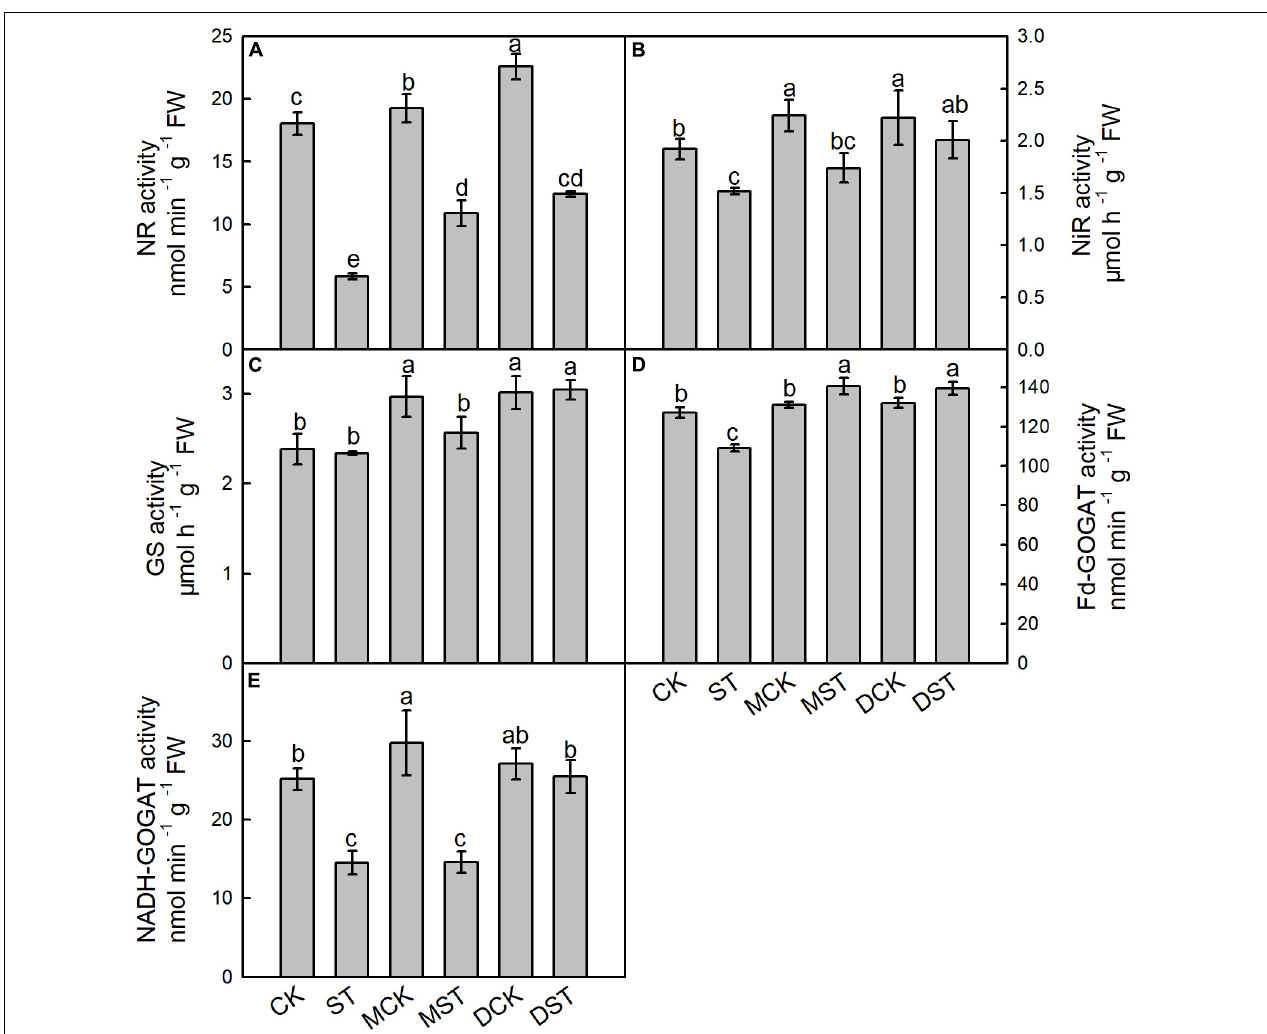
FIGURE 5 | Effects of melatonin and dopamine on activities of nitrate reductase (NR; A ), nitrite reductase (NiR; B ), glutamine synthetase (GS; C ), ferredoxin-dependent glutamate synthase (Fd-GOGAT; D ), and nicotinamide adenine dinucleotide (NADH-GOGAT; E ) in roots under different treatment conditions. Data are means ± SD ( n = 3). Values not followed by same letter denote significant differences by Tukey’s multiple range tests ( P < 0.05). CK, 2 mM K 15 NO 3 solution; ST, 0.1 mM K 15 NO 3 solution; MCK, 2 mM K 15 NO 3 solution with 0.1 µ mol/L melatonin; MST, 0.1 mM K 15 NO 3 solution with 0.1 µ mol/L melatonin; DCK, 2 mM K 15 NO 3 solution with 100 µ mol/L dopamine; DST, 0.1 mM K 15 NO 3 solution with 100 µ mol/L